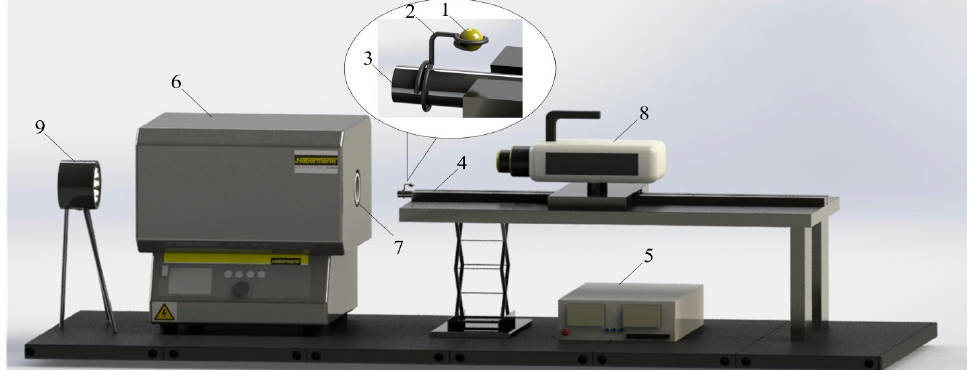
Figure 2. Experimental setup: 1—liquid droplet; 2—holder; 3—steel tube; 4—coordinate mechanism; 5—control unit of the coordinate mechanism; 6—muffle furnace; 7—ceramic tube; 8—high-speed video camera; 9—LED lamp.